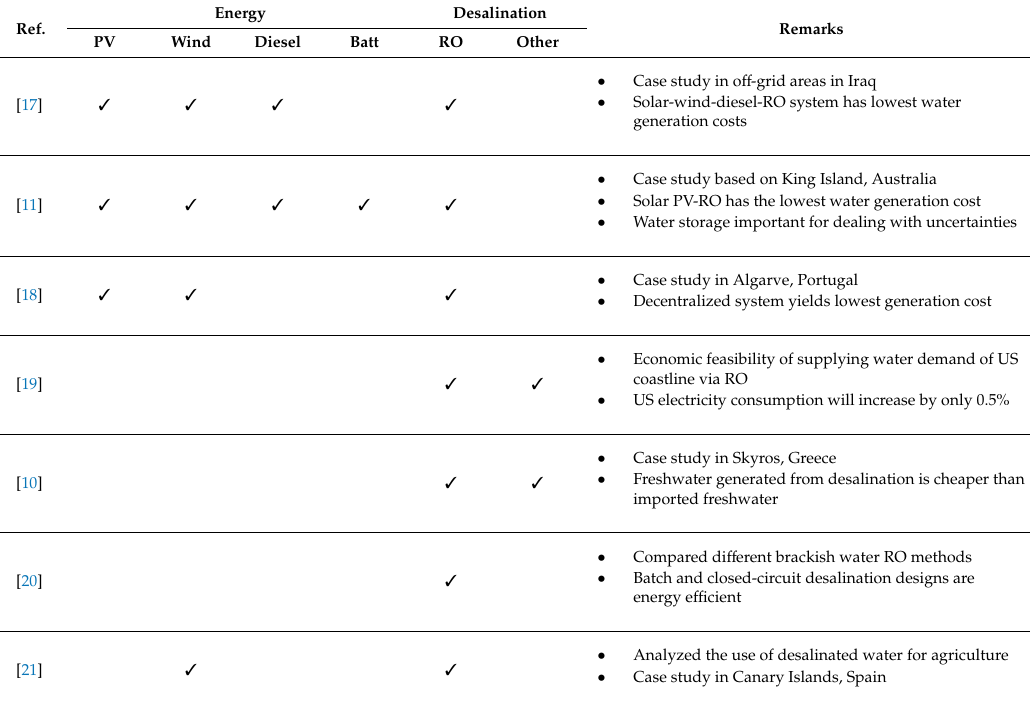
Table 1. Summary of energy-desalination feasibility studies. RO: reverse osmosis; PV: photovoltaic.